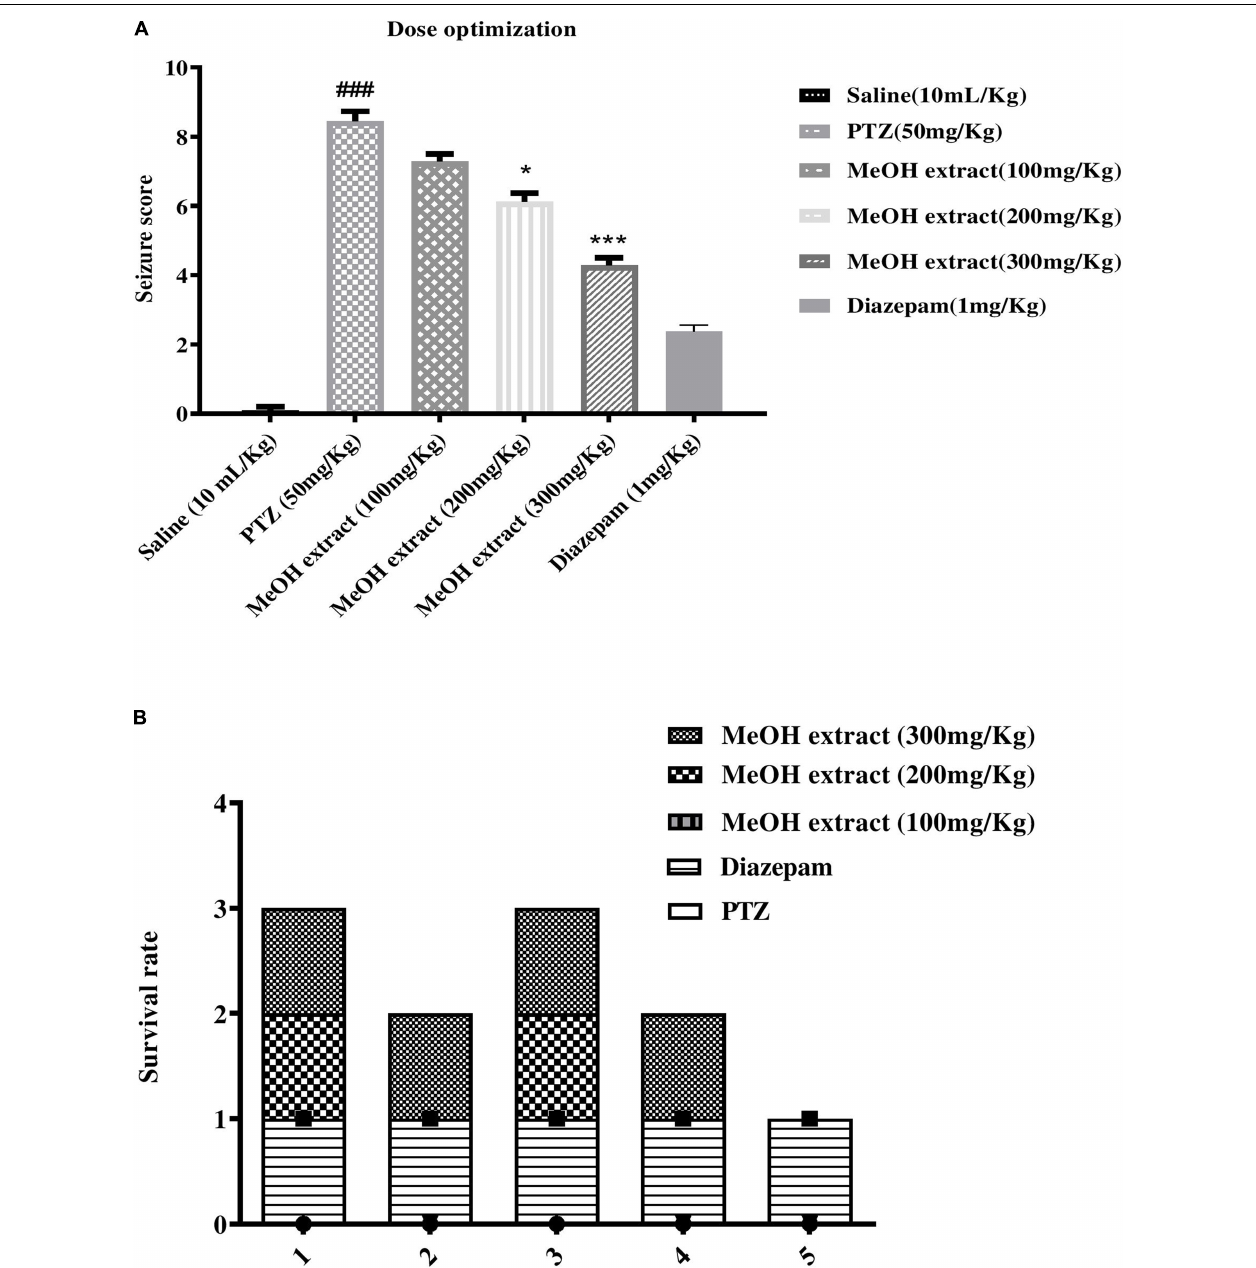
FIGURE 6 | (A) Graph showing effect of different dosses of O. limbata against convulsion induced by PTZ in mice model. Symbols *indicates p < 0.05 and *** or ### indicates p < 0.001. Symbols # shows a considerable difference compared to the saline group, while *shows a considerable difference compared to the PTZ group. (B) Showing% mortality of